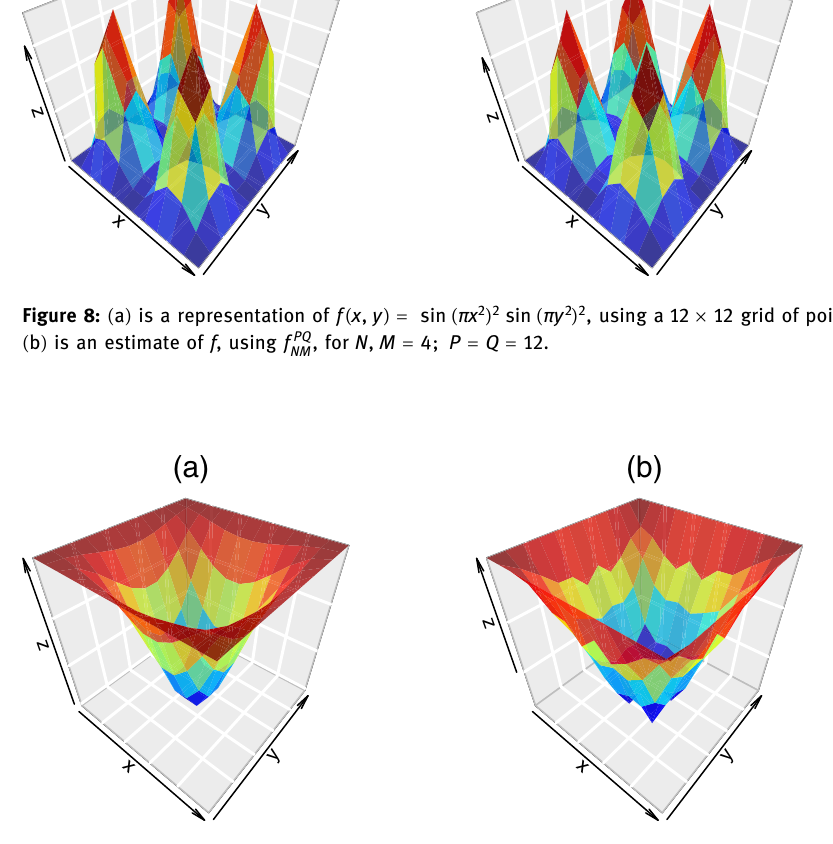
Figure 9: ( a ) is a representation of ( × 12 12 grid of points. ( b ) is an estimate of f , using f NMPQ , for